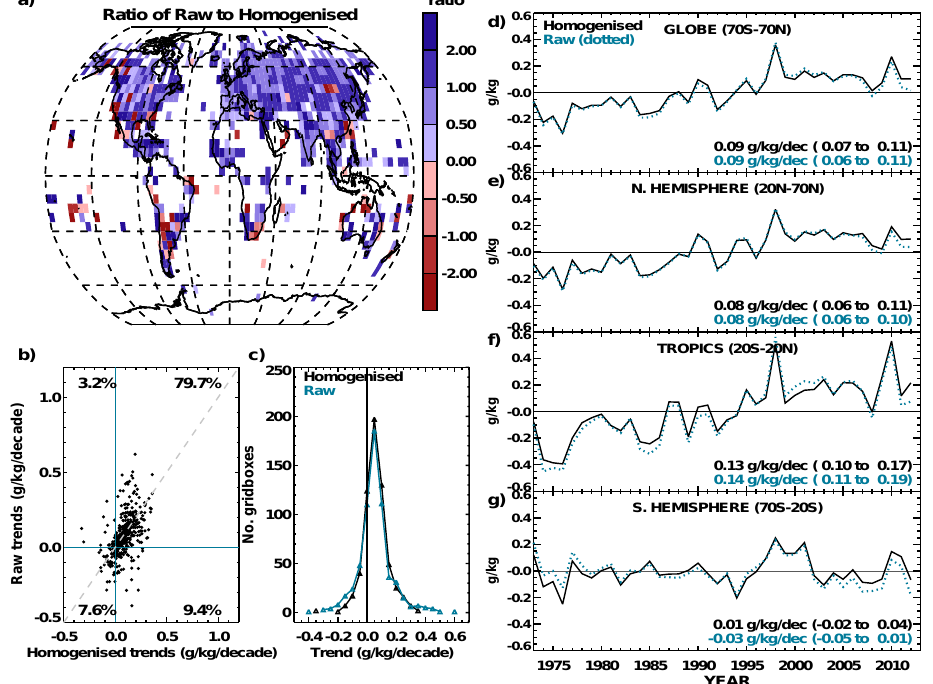
Fig. 5. Difference between trends (1973–2012) in HadISDH before and after the pairwise homogenisation process. (a) Ratio of decadal trends from the raw HadISDH compared to homogenised HadISDH (trend methodology is described in Fig. 9). Note non-linear colour bars. (b) Scatter relationship between homogenised and raw decadal trends for HadISDH. The percentage of grid boxes present in each quadrant is shown. (c) Distribution of grid-box trends for the homogenised and raw data. (d – g) Large-scale area average annual anomaly time series and trends for homogenised HadISDH and the raw data relative to the 1976–2005 climatology